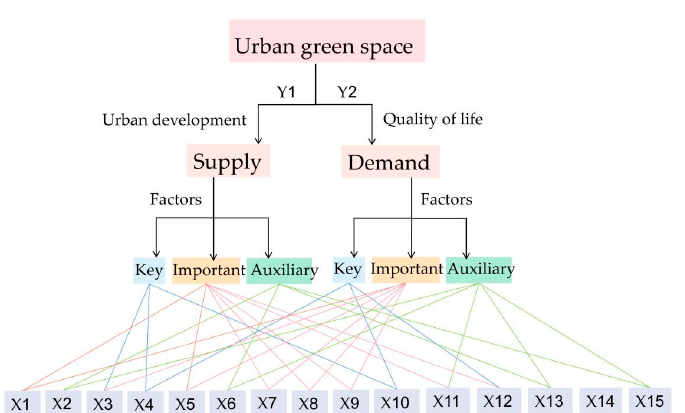
15 of 22 Table 5. Classify the driving factors: blue represents “Key factors”, orange represents “Important factors”, and green represents “Auxiliary factors”.